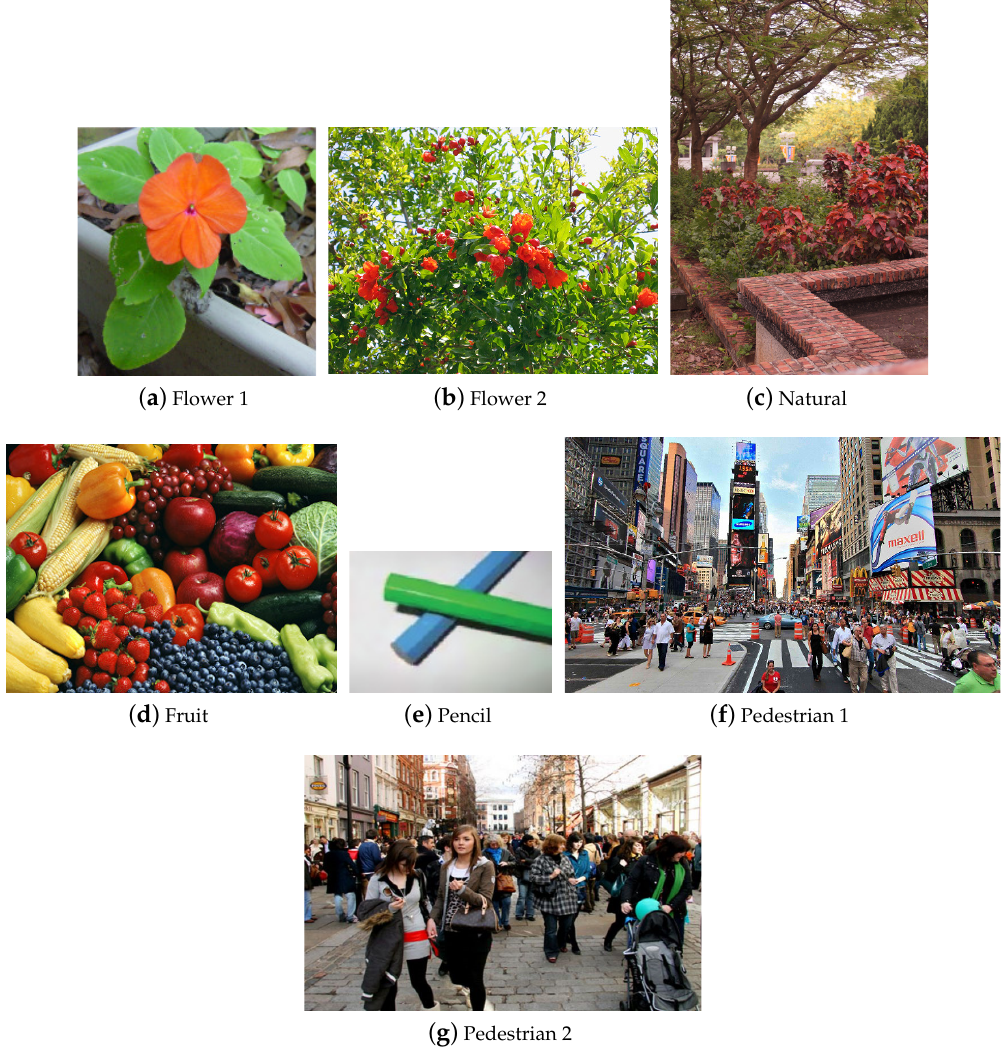
Figure 10. The test images used to evaluate the re-coloring techniques for color vision